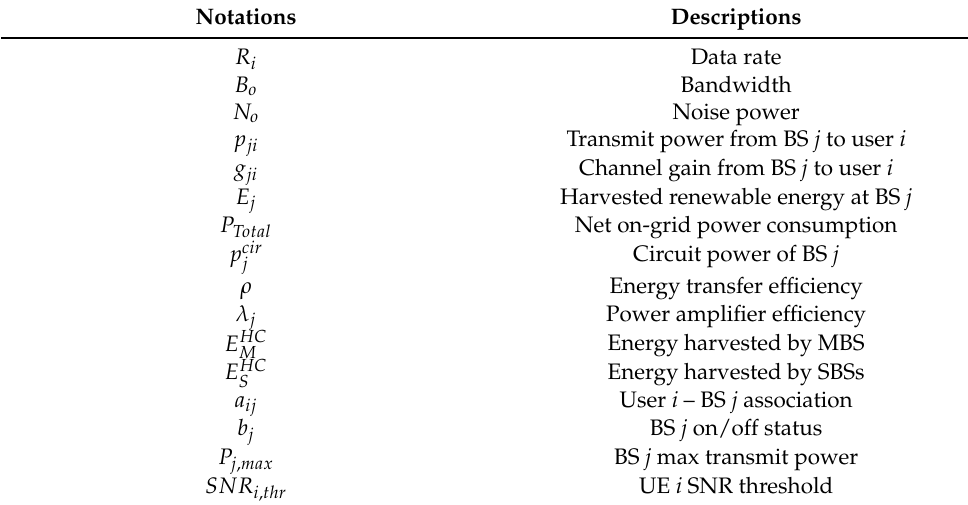
Figure 2. CoMP-enabled hybrid-powered MBS and SBSs connected to a smart grid in HetNet architecture. Table 2. List of main variables and